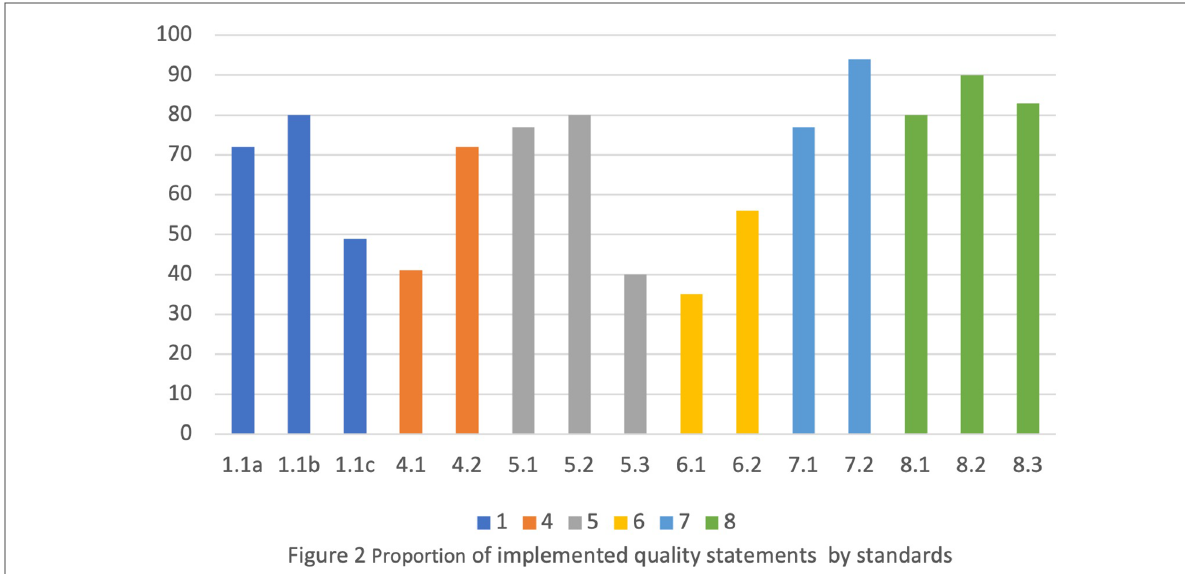
FIGURE 2 Proportion of implemented quality statements by standards.